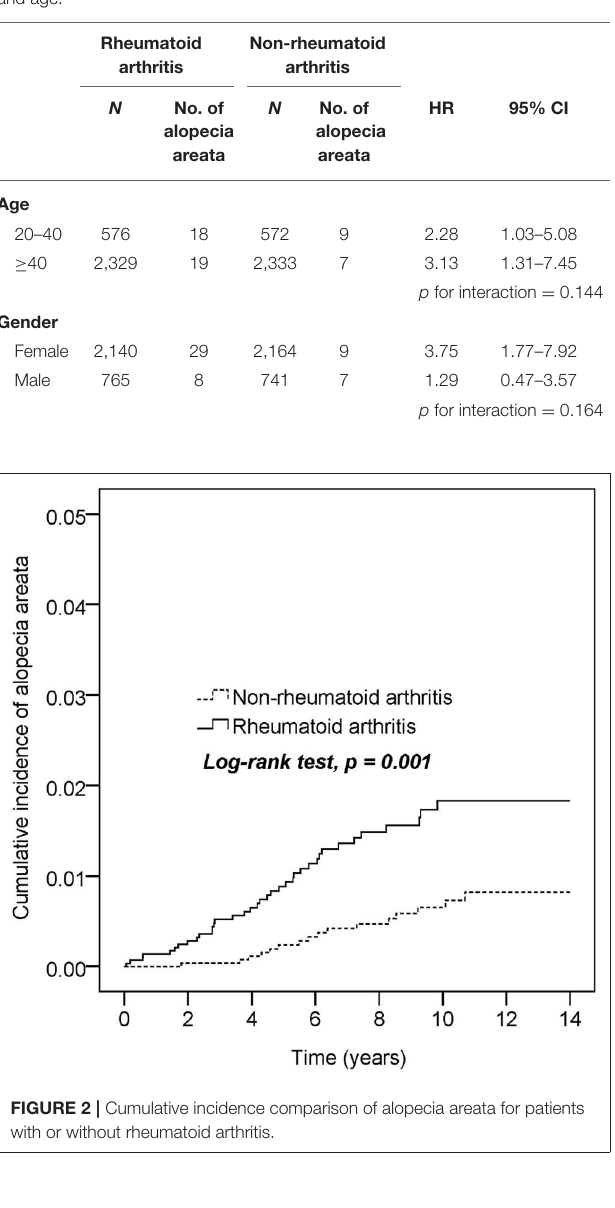
cohort, RA remains an independent risk factor for